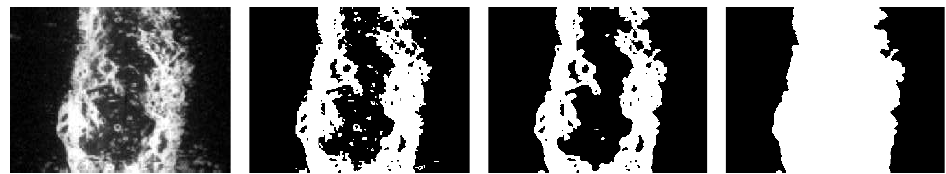
Figure 9. Image processing steps performed by the MATLAB code. From left to right: raw image obtained by the high-speed camera, binary image, image after the moving average filter, and final image with holes